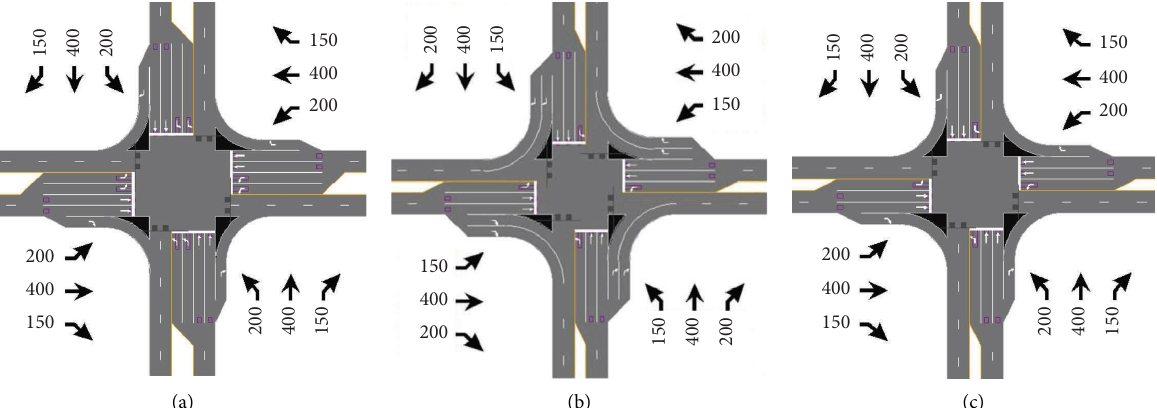
Figure 3: Sample of simulated scenarios in Synchro: (a) dual left-turn lanes, (b) dual right-turn lanes, and (c) single right- and left-turn lanes.